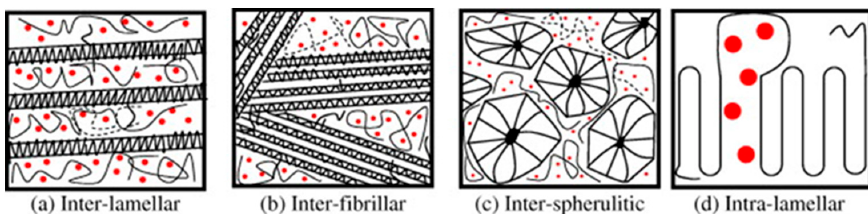
Figure 3. Possible mechanisms of segregation in drug/polyethylene oxide solid dispersion: inter-lamellar ( a ), inter-fibrillar ( b ), inter-spherulitic ( c ) and intra-lamellar ( d ). Red points represent drug molecules. Reproduced with permission from [24].